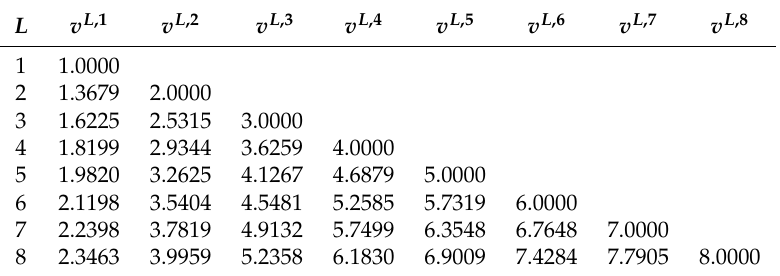
Table 3. The values for the exponential distribution Exp ( 1 )